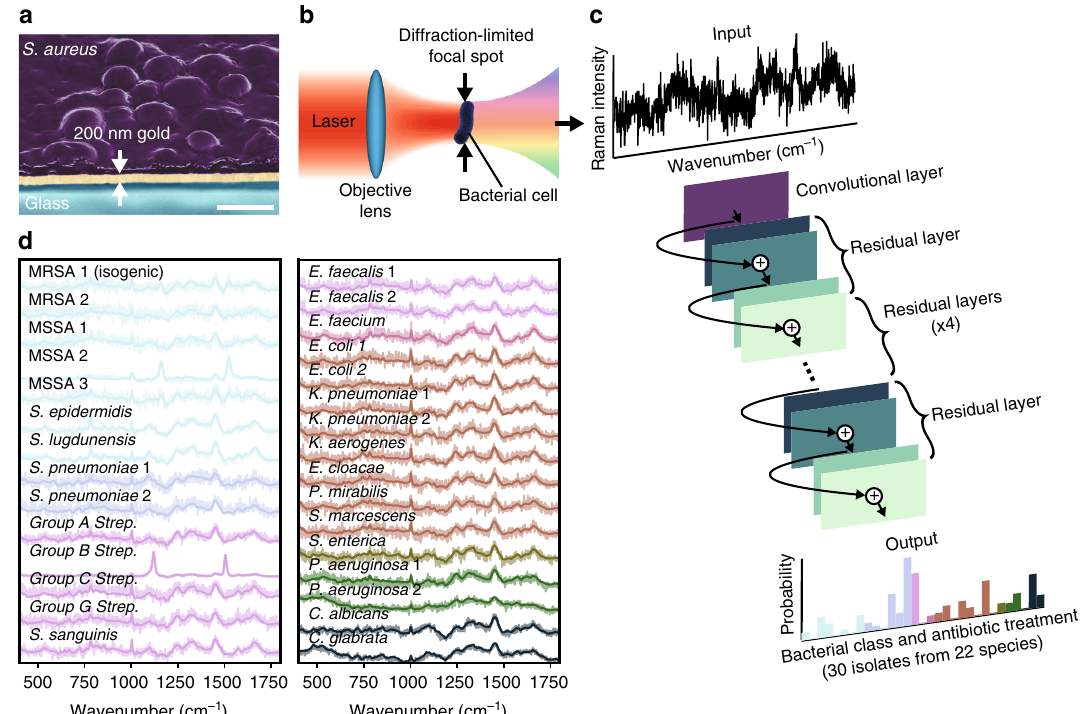
Fig. 1 A convolutional neural network (CNN) can be used to identify bacteria from Raman spectra. a To build a training dataset of Raman spectra, we deposit bacterial cells onto gold-coated silica substrates and collect spectra from 2000 bacteria over monolayer regions for each strain. An SEM cross section of the sample is shown (gold coated to allow for visualization of bacteria under electron beam illumination). Scale bar is 1 µ m. b Conceptual measurement schematic: by focusing the excitation laser source to a diffraction-limited spot size, Raman signal from single cells can be acquired. c Using a one-dimensional residual network with 25 total convolutional layers (see Methods for details), low-signal Raman spectra are classi fi ed as one of 30 isolates, which are then grouped by empiric antibiotic treatment. d Raman spectra of bacterial species can be dif fi cult to distinguish, and short integration times (1 s) lead to noisy spectra (SNR = 4.1). Averages of 2000 spectra from 30 isolates are shown in bold and overlaid on representative examples of noisy single spectra for each isolate. Spectra are color-grouped according to antibiotic treatment. These reference isolates represent over 94% of the